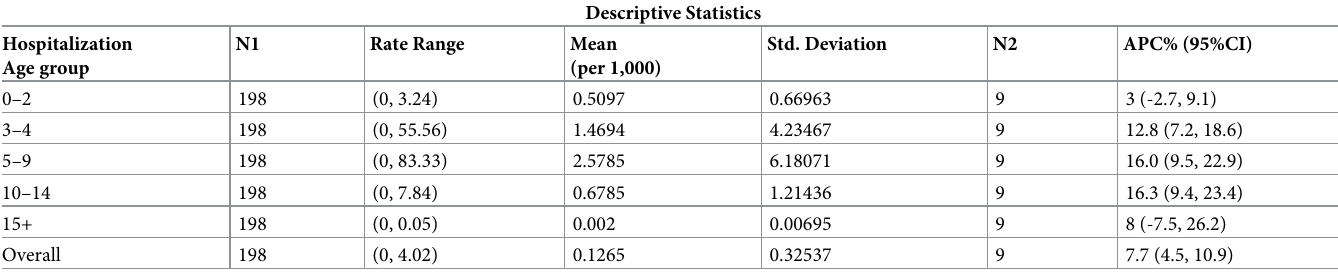
Table 2. Descriptive statistics on annual rate of scarlet fever in inpatient setting from 2009 to 2017 and annual percentage change